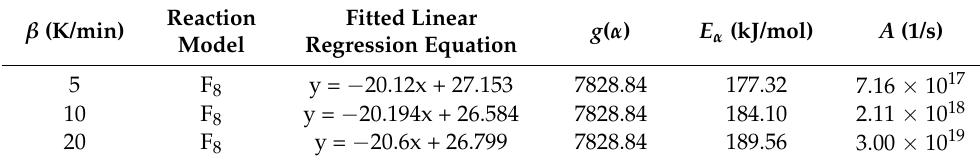
Table 3. Kinetic parameters and fitted linear regression equations.